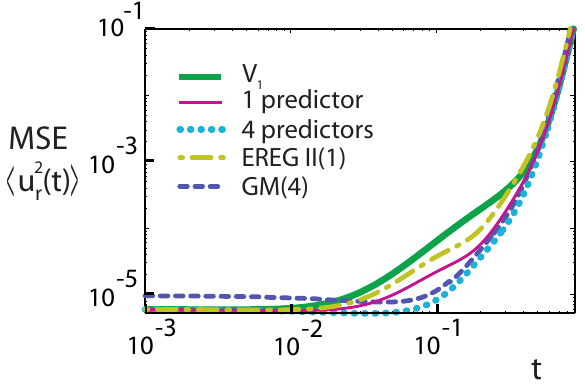
Fig. 3. The long lead time mean square error (MSE) evolution for Lorenz model with small model error ( δr = 2 . 5 × 10 − 3 ) and with 5 × 10 5 ensembles of 500 members. The number after the regression method denotes the predictor number.